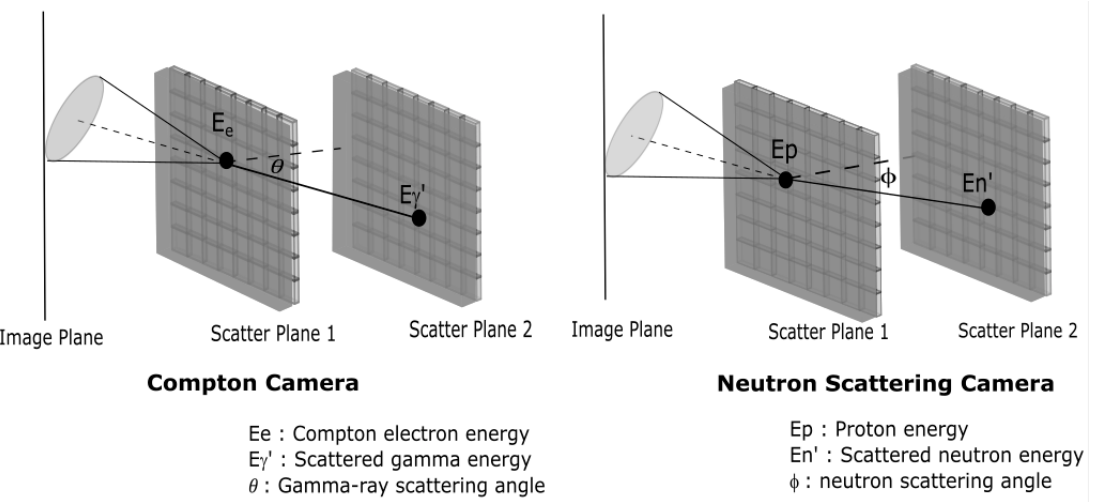
Figure 6. Schematic of basic parameters in Compton scattering camera ( left ) and neutron scattering camera ( right ).